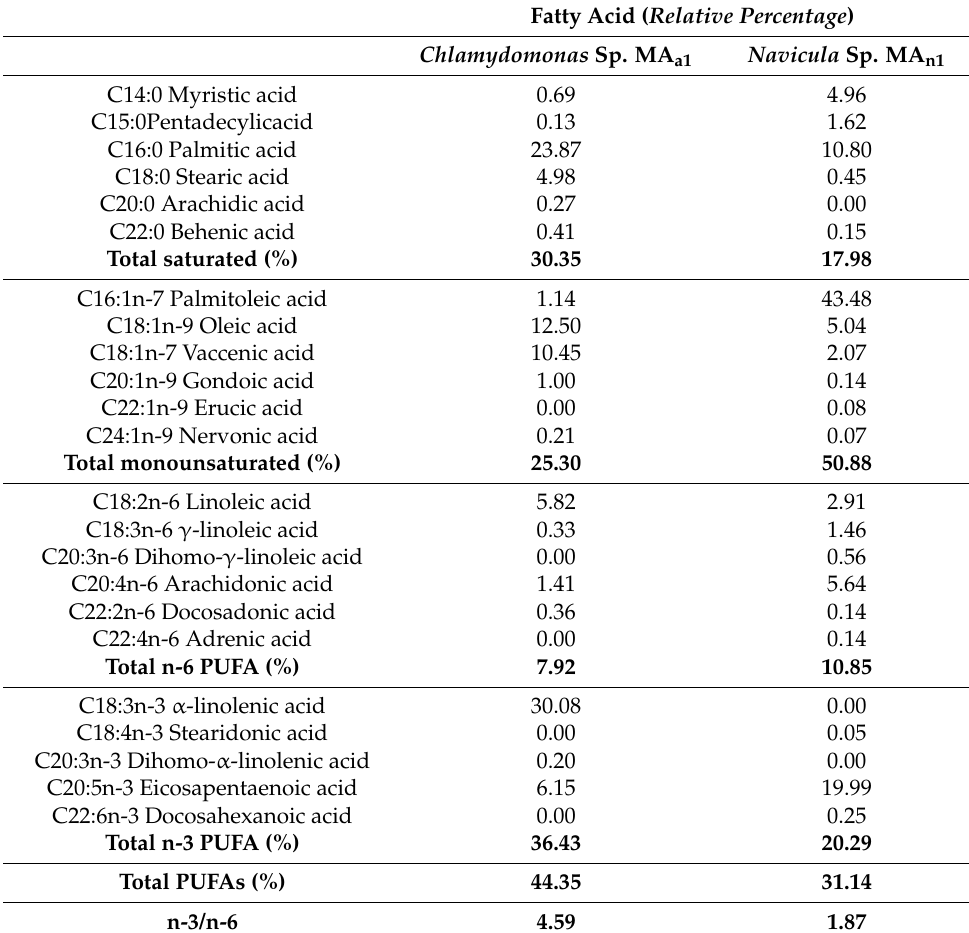
Table 2. Fatty acid compositional profiles of lipid extracts from microalgae